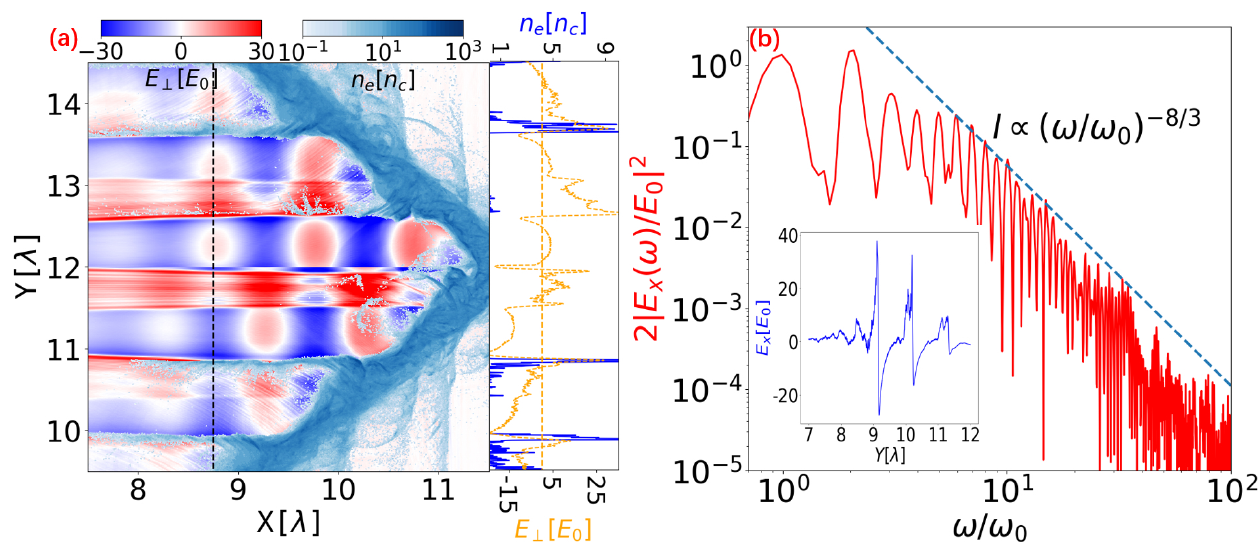
Figure 2. (Color online). ( a ) The distributions of the electric field perpendicular to the target E ⊥ (normalized to E 0 ) and electron density n e (normalized to n c ) at t = 15 T 0 . The mini figure on the right shows the distributions of E ⊥ and n e at x = 8.75 λ 0 (the black dotted line), in which, the yellow dotted line represents E ⊥ and the blue dotted line represents n e . There are three electron bunches near y = 10 λ 0 , y = 11 λ 0 and y = 13.6 λ 0 in the vacuum at the inner side of the target. ( b ) Spectrum of HHG at 13.25 T 0 , conforms to the power-law of ROM I ∝ ( ω / ω 0 ) − 8/3 . The inset is the distribution of the reflected field E x